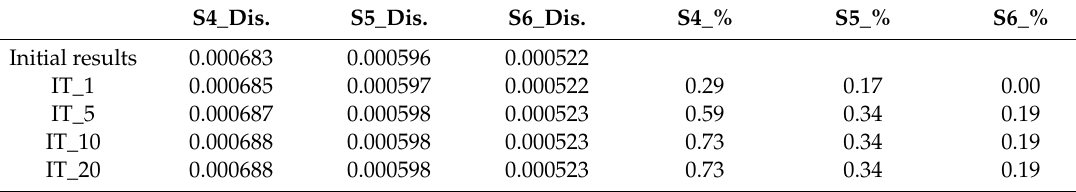
Figure 5. The amount of strain change gradually stabilized in S4, S5, and S6 screws with the increase in the number of iteration analyses. Table 2. Micro-movement of the S5, S6, and S7 screws at different iterations (unit: mm).